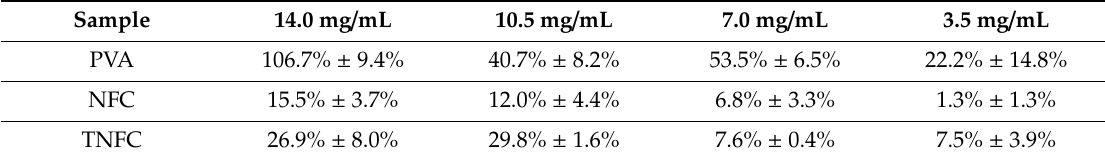
Table 2. Ending drug release percentage from PVA, NFC, and TNFC films at each drug concentration after 144 h.